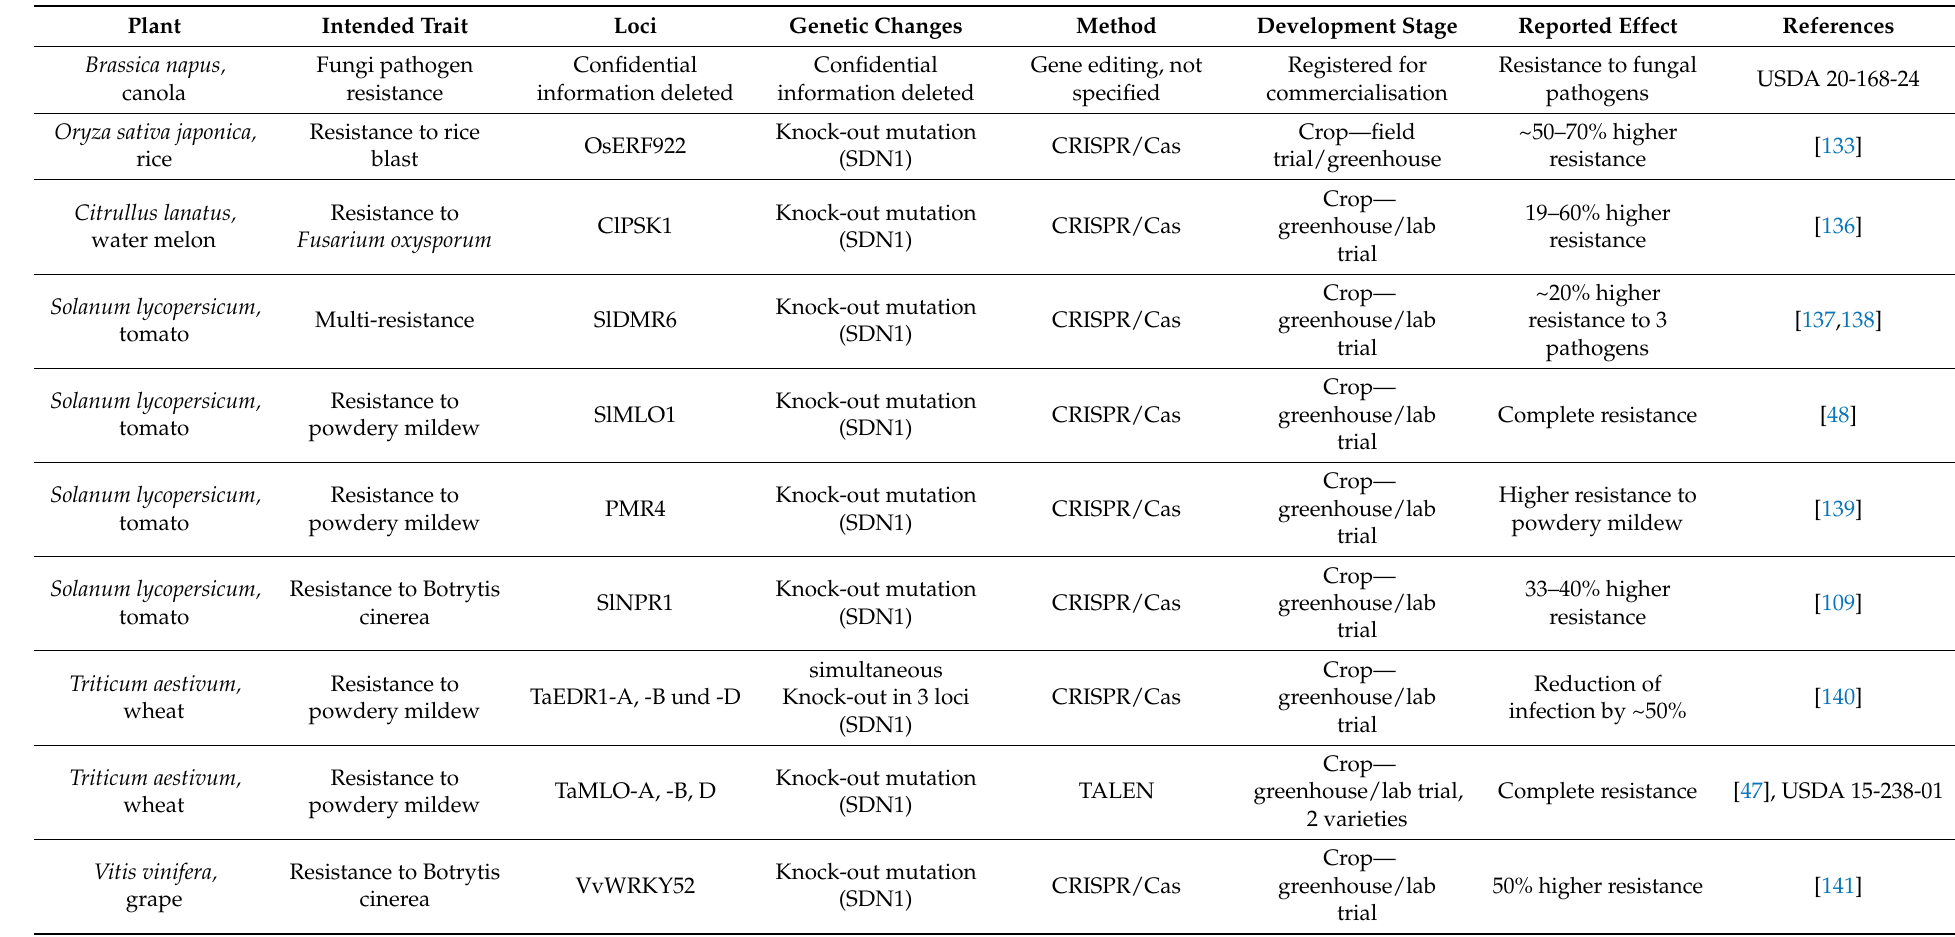
Table 4. Overview of the plants under development with NGT aiming at resistance to filamentous